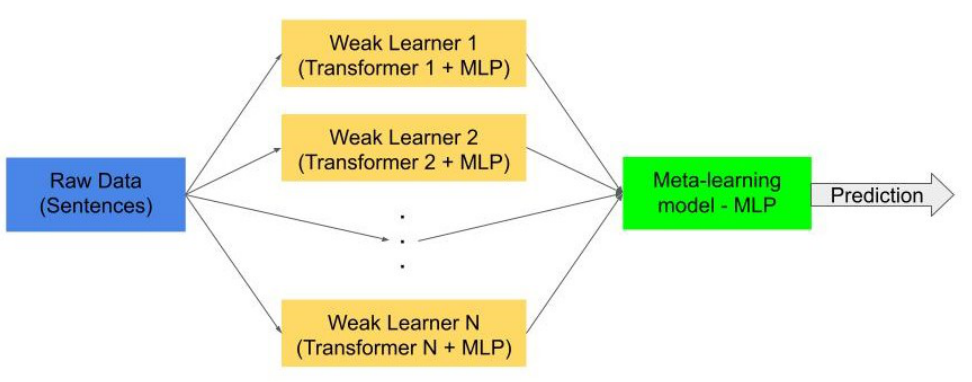
Figure 3. Stacked ensemble architecture implemented.